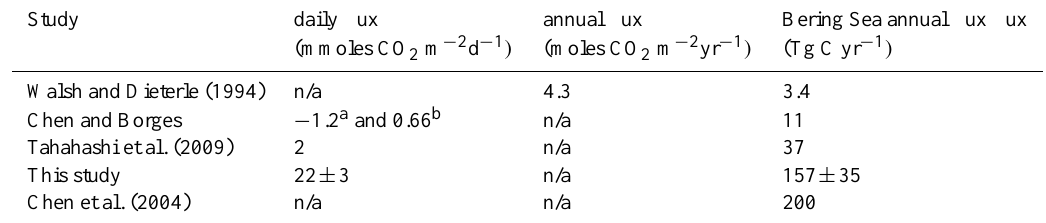
Table 1. Estimates of the annual air-sea CO 2 flux on the Bering Sea shelf, assuming 500,000 km 2 of shelf area, and 180days of open water.